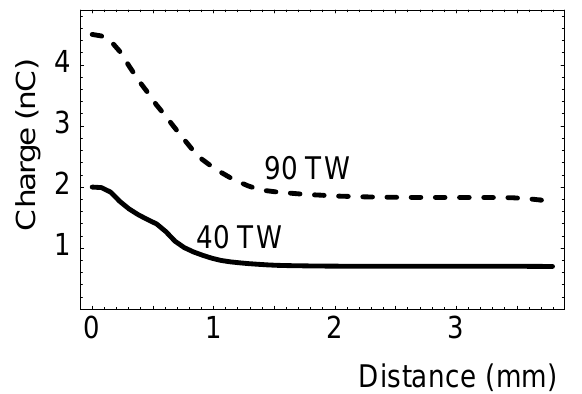
FIG. 13. Trapped charge as a function of propagation distance for the 40 TW case and the 90 TW case. influence of wakefield nonlinearities is small for the pa- rameters of our simulations, in spite of a relatively high wakefield amplitude.